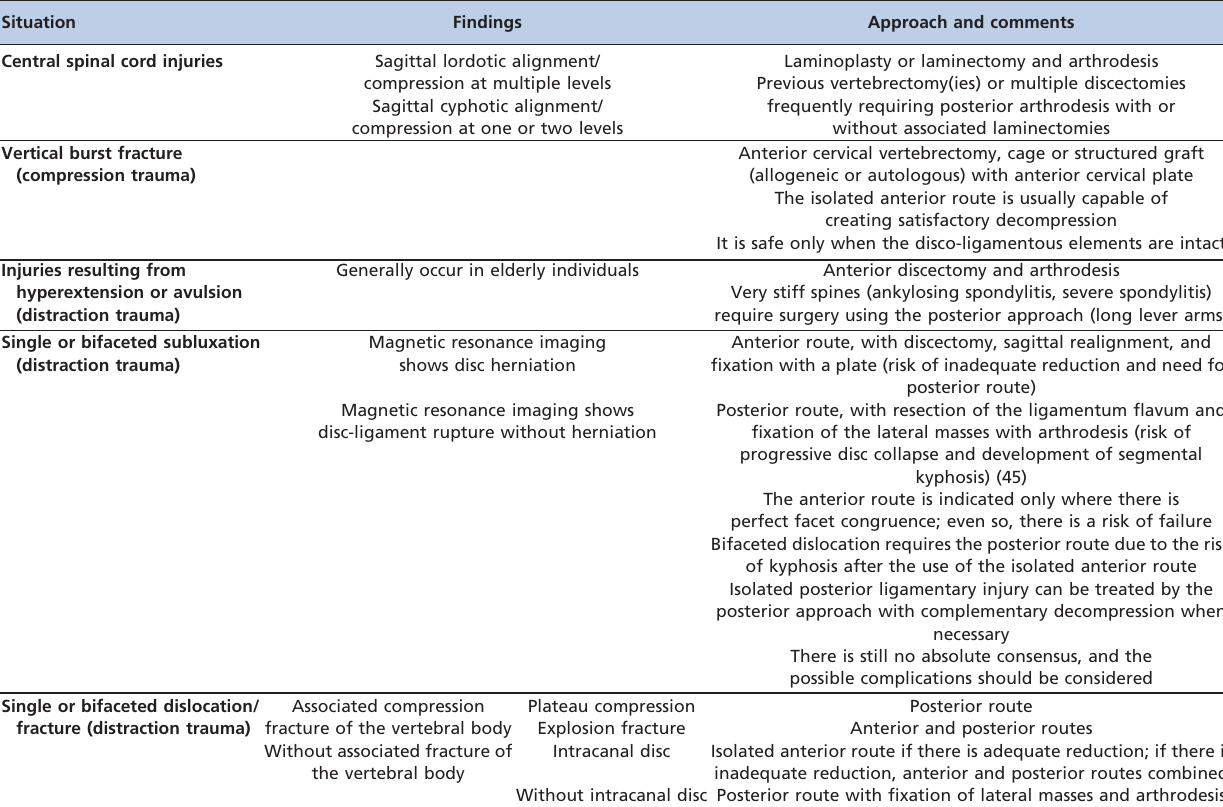
Table 2 - Guidelines for the surgical treatment (32) of cervical